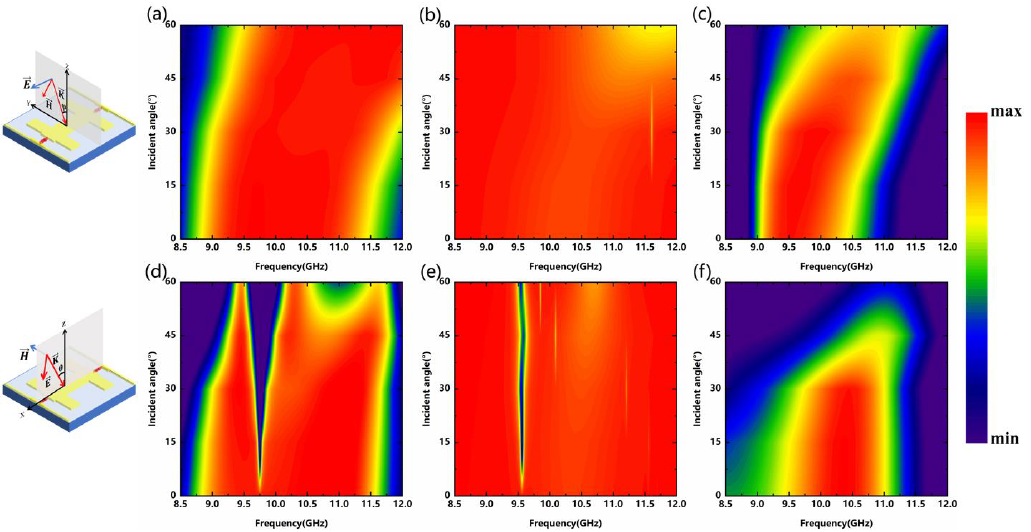
Figure 5. ( a ) Transmission spectra; ( b ) Reflection spectra; ( c ) Absorption spectra of the TE modes at different oblique incident angles; ( d ) Transmission spectra; ( e ) Reflection spectra; ( f ) Absorption spectra of the TM modes at different oblique incident angles.